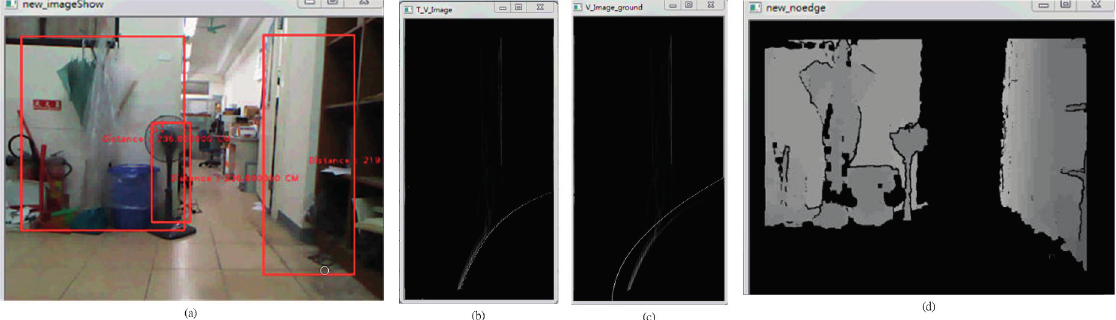
Figure 10. Offset value = 20. ( a ) Real scene; ( b ) No LSM Curve; ( c ) LSM Curve without offset; ( d ) Depth